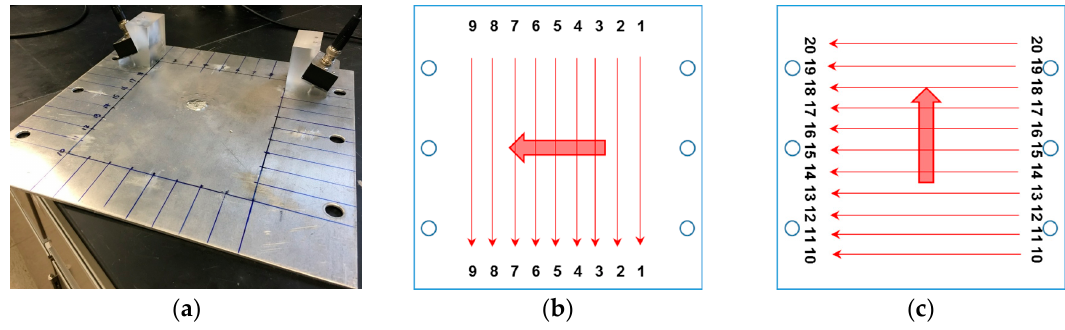
Figure 15. ( a ) Photograph of damage characterization through twenty scanning paths; ( b ) nine vertical paths; and ( c ) eleven horizontal paths.